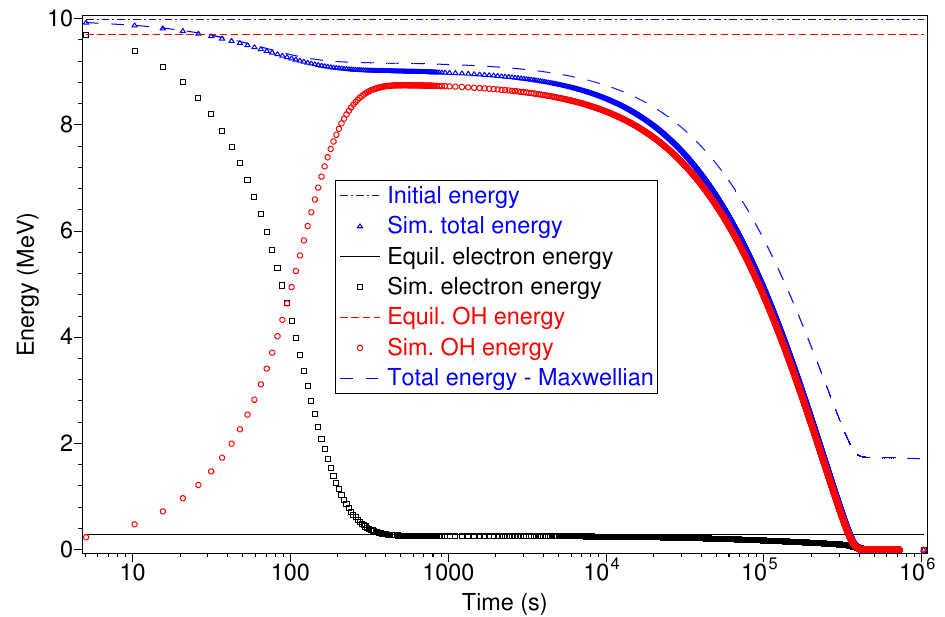
Figure 10. The previous simulation with elastic scattering from the gas molecules added. The total energy (vibrational + electron energy) is shown for: ( (cid:52) ) implementation of Equation (28) as rate equations in the simulation and (— — ) point-by-point application of Equation